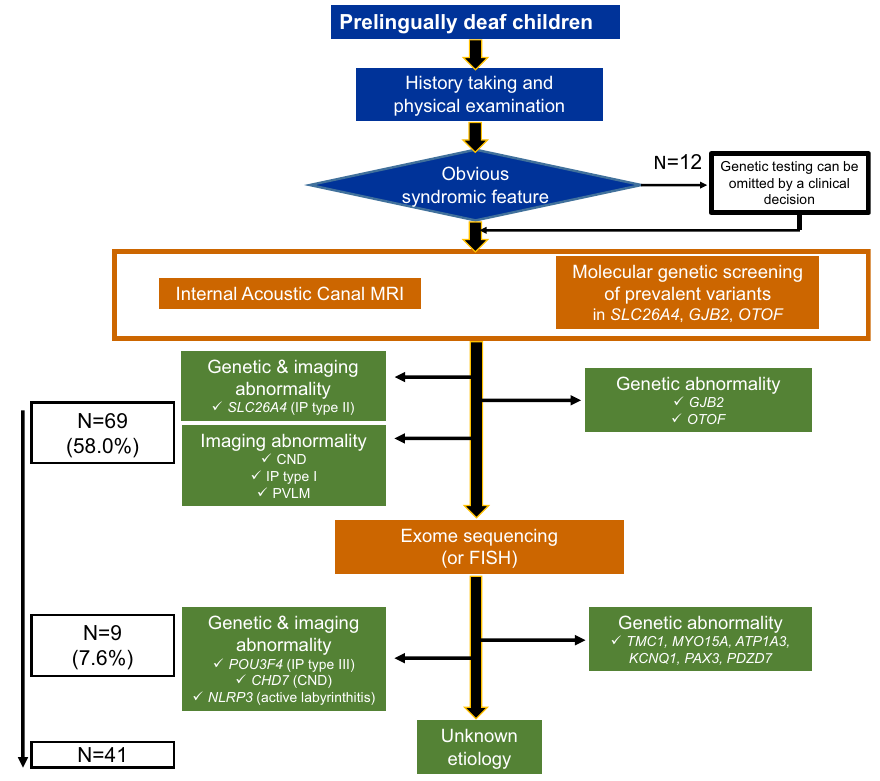
Figure 2. Systematic etiologic diagnostic flowchart used in our study. First line screening using internal auditory canal MRI in tandem with molecular screening of prevalent variants enables etiologic identification in 58.0% of subjects. Subsequent in-depth genetic testing elucidates molecular etiology in 9 more subjects (7.6%), leaving 41 subjects etiologically